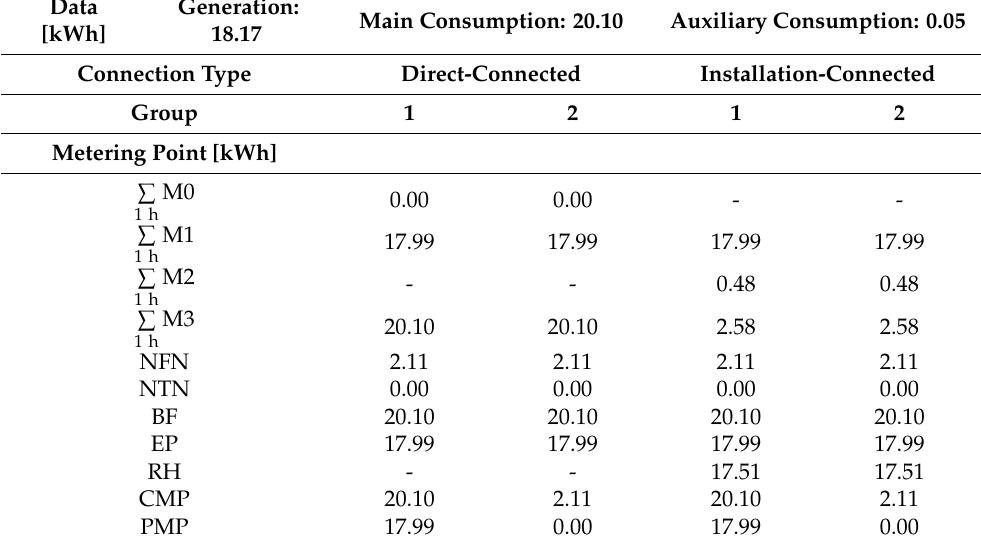
Table 5. Energy registered by the different metering points during the time interval 15:00–16:00 in coordinated universal time (UTC).